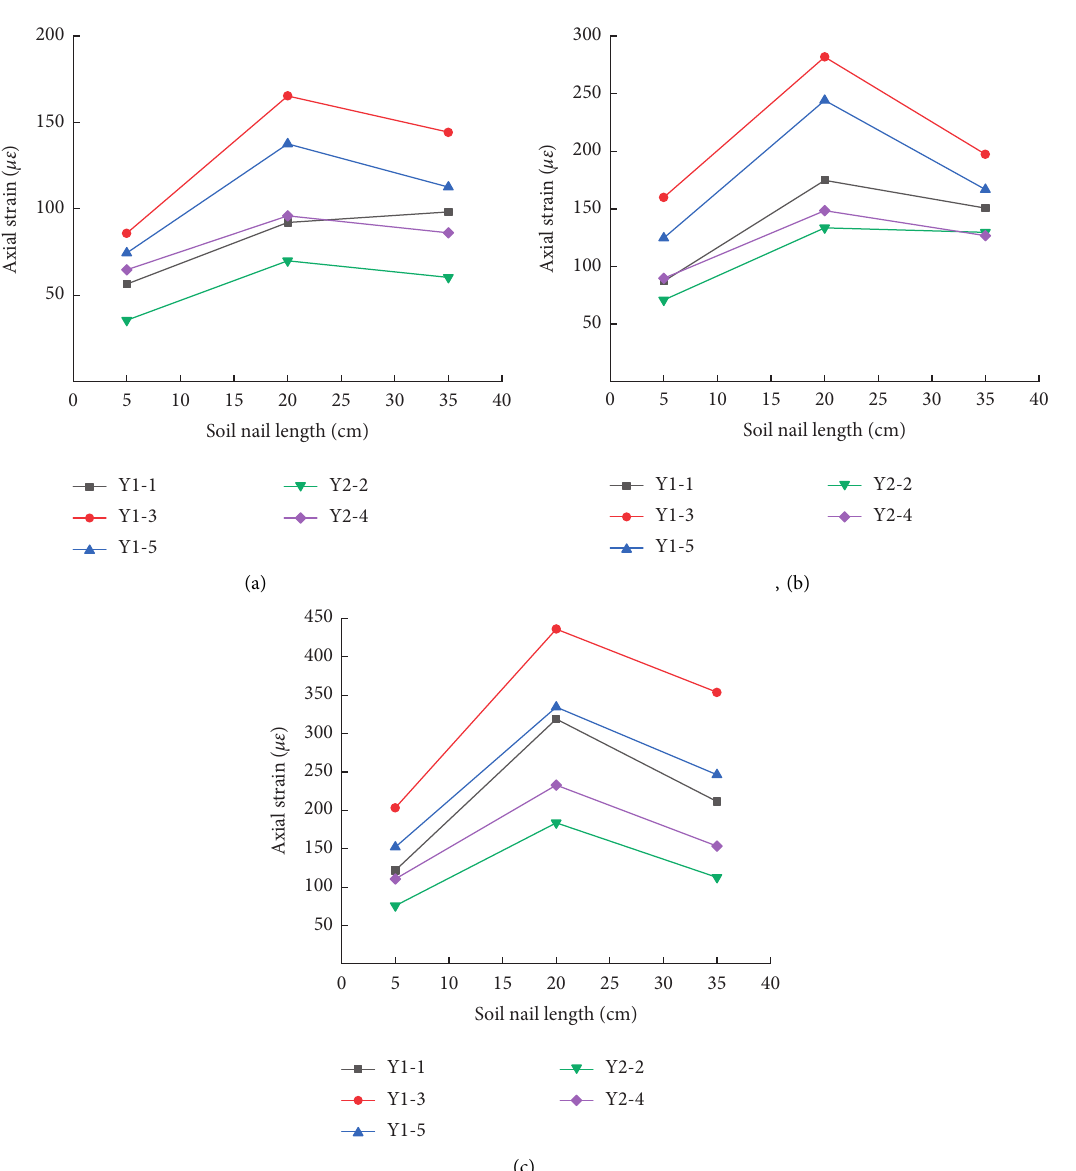
Figure 8: Axial strain distribution curves of the soil nail under (a) 3kPa, (b) 6kPa, and (c)